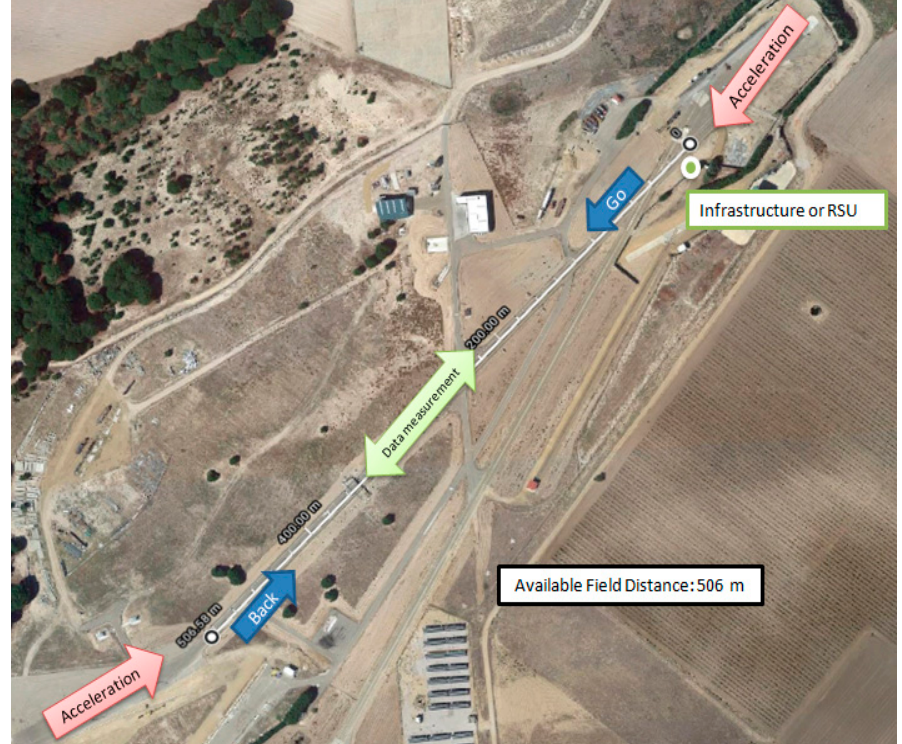
Figure 6. Design of preliminary tests in Boecillo.